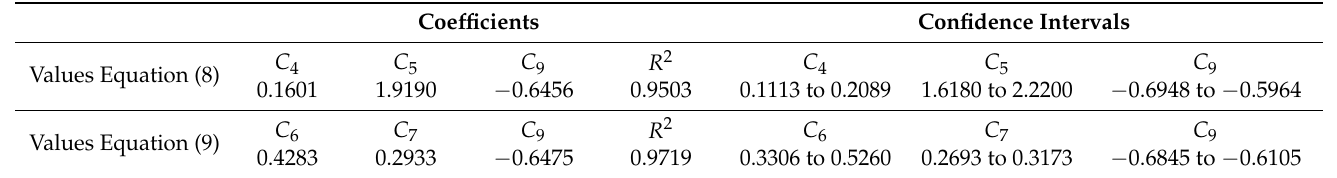
Table 2. Coefficients and confidence intervals for Equation (8) [50] and Equation (9) [51]. Coefficients Confidence